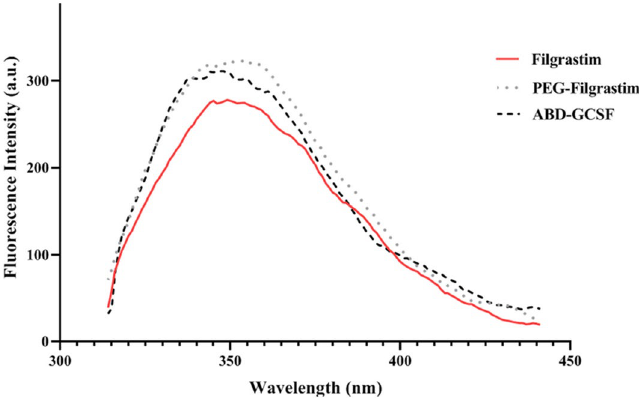
Figure 5. Fluorescence emission spectra of GCSF derivatives.